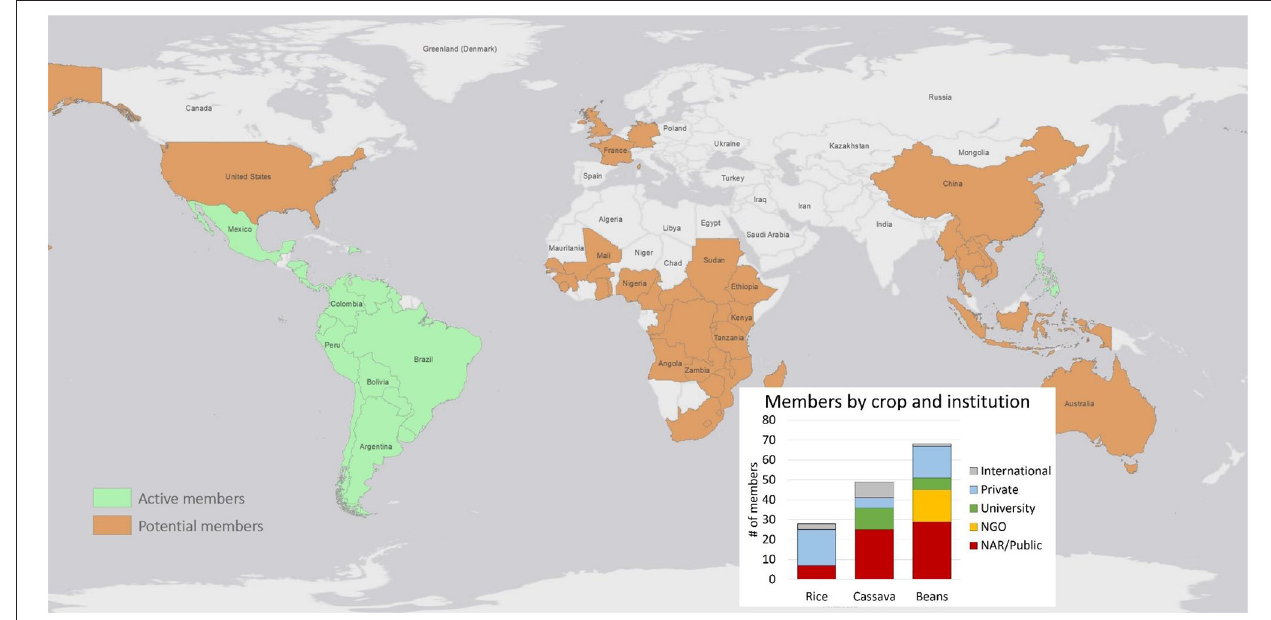
FIGURE 5 | Countries where active and potential observatory partners are located by crop and type of institution,